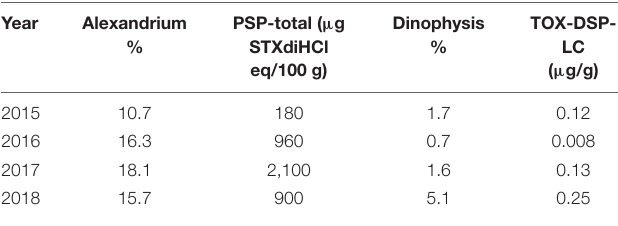
TABLE 7 | Alexandrium and Dinophysis frequency of occurrence (%) and maximum toxin concentrations (data source: Canadian Food Inspection Agency) in February–October, Strait of